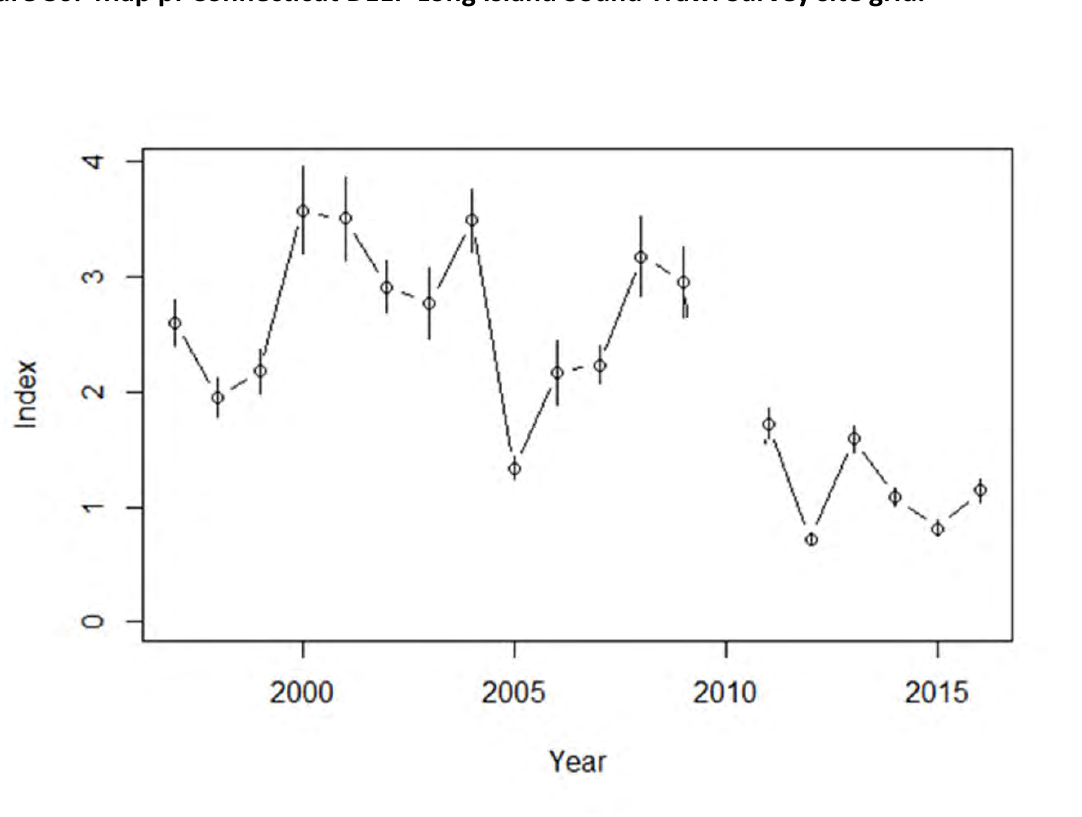
Figure 31. Index of relative abundance of horseshoe crab (delta mean catch per tow) developed from the fall portion of Connecticut DEEP Long Island Sound Trawl Survey with 95% confidence